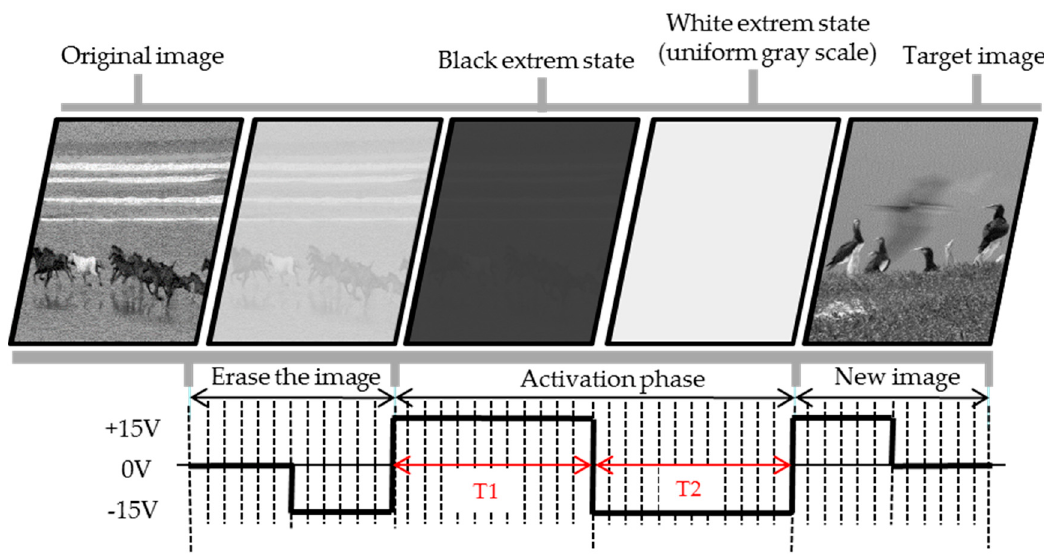
Figure 2. A typical EPD conventional driving waveform contains three phases for image updating. The T1 phase is used as improving particle activity phase and the T2 phase is used as uniform reference grayscale phase in the activation phase. The image in T1 is erased in T2.